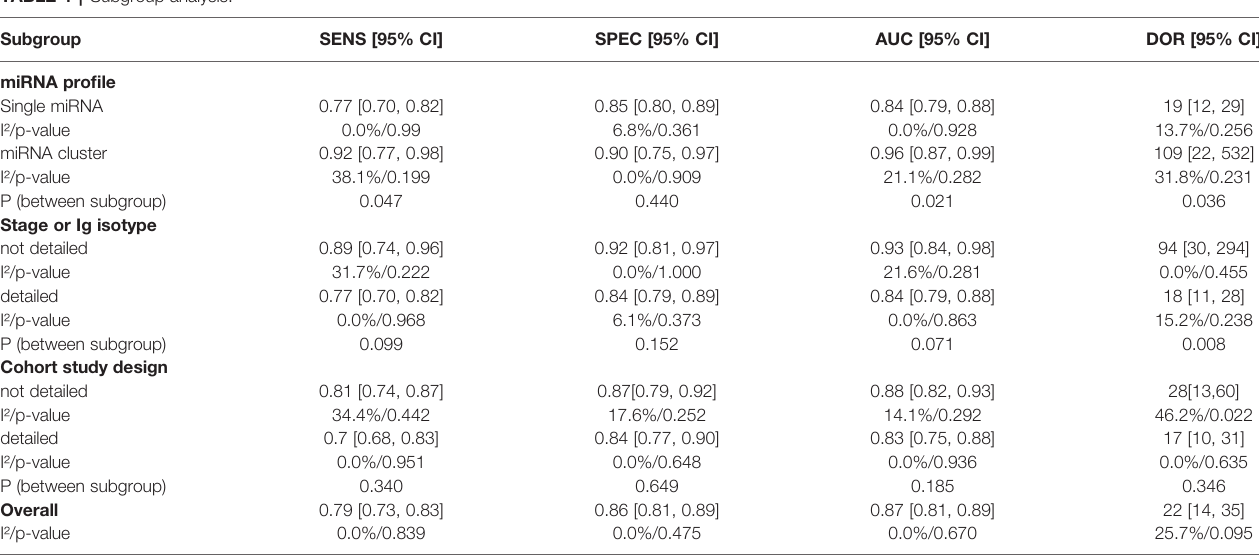
TABLE 4 | Subgroup